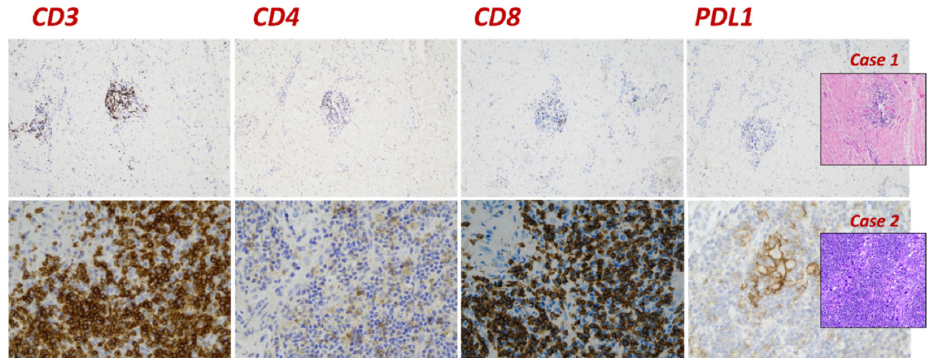
Figure 2. Immunohistochemistry results highlighting the inflammatory component in case 1 ( top row ) and in case 2 ( bottom row ). The greater part of inflammatory cells is represented by CD3-positive T lymphocytes, although there are both T helper CD4 (faint staining) and T cytotoxic CD8 (strong staining) lymphocytes; however, only the second case shows PD-L1 expression (22C3 DAKO–CPS > 10) on both in fl ammatory and neoplastic cells.